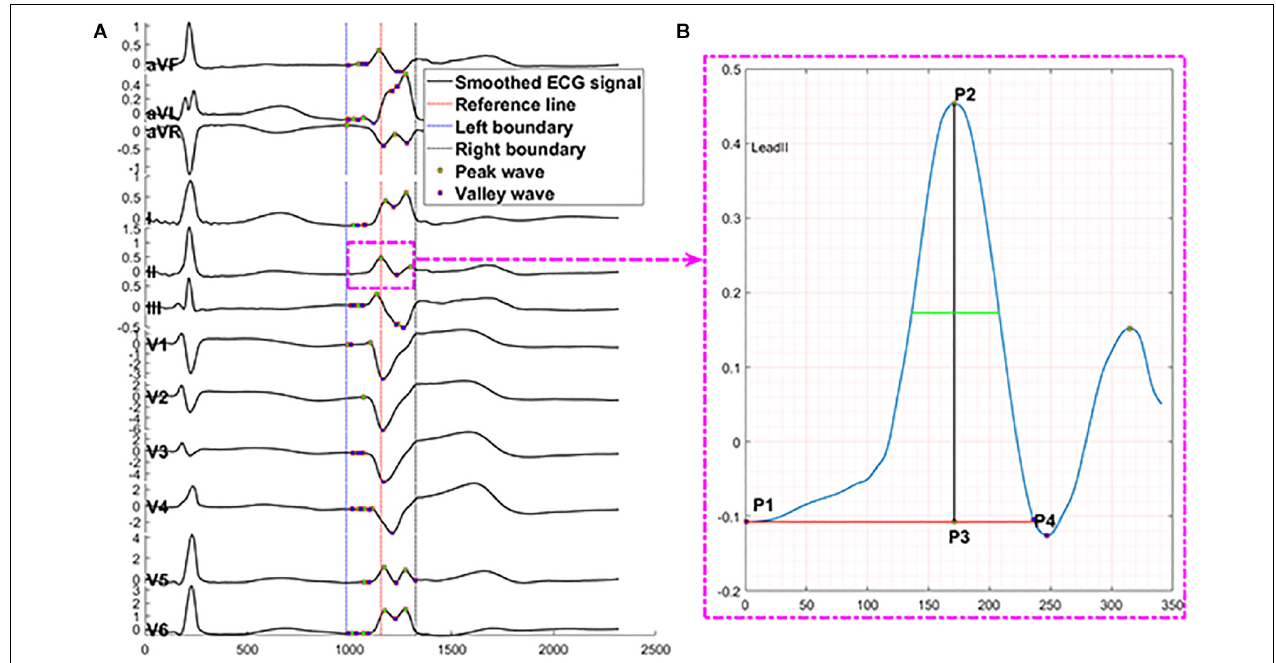
FIGURE 4 | Description of automated ECG feature extraction method. The proposed feature extraction method automatically finds peaks presented by P# and valleys presented by V# in panel (A) through 430 data points of one SR beat in 12 leads. Panel (B) presents the numerical measurements that capture essential information of a peak, including location = sample points at P3, prominence = distance from P2 to P3, distance from peak or valley location to left prominence boundary = distance from P1 to P3, distance from peak or valley location to right prominence boundary = distance from P3 to P4, width at half of the prominence = the length of green line, distance from left prominence boundary to right prominence boundary = distance from P1 to P4, amplitude = distance from P2 to zero baseline, contour height = prominence – amplitude. X -axis presents sampling data points, and Y -axis presents